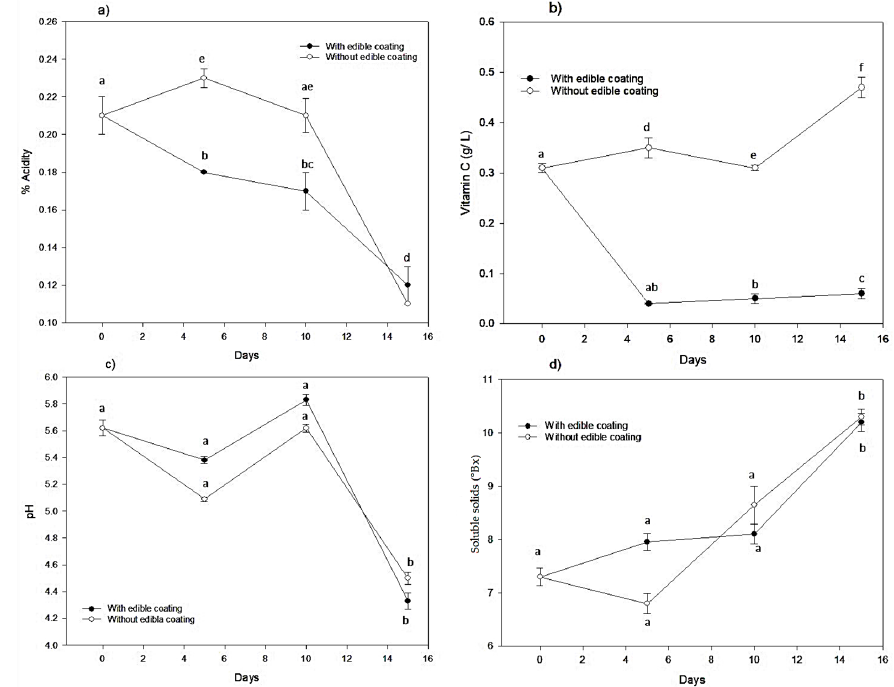
Figure 3. Chemical changes during papaya ripening, coated and uncoated, during storage time at room temperature: ( a ) titratable acidity (% cítric acid); ( b ) vitamin C (g/kg); ( c ) pH; ( d ) soluble solids. a–f: used on top of reported values, indicate that if the same letter appears at different times, the values compared are not significantly different ( p >